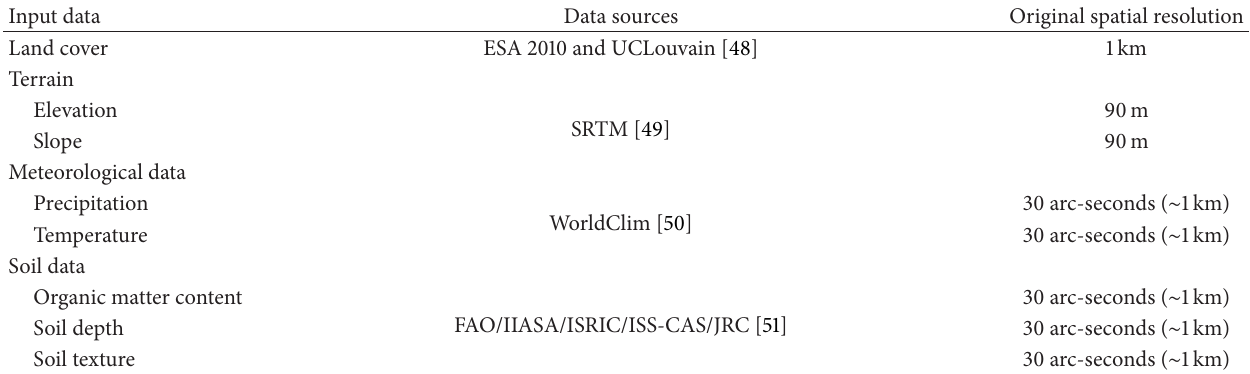
Figure 1: Evaluation of spatial distribution and suitability of marginal land resources for energy plants. Table 1: Input data for identification of marginal land